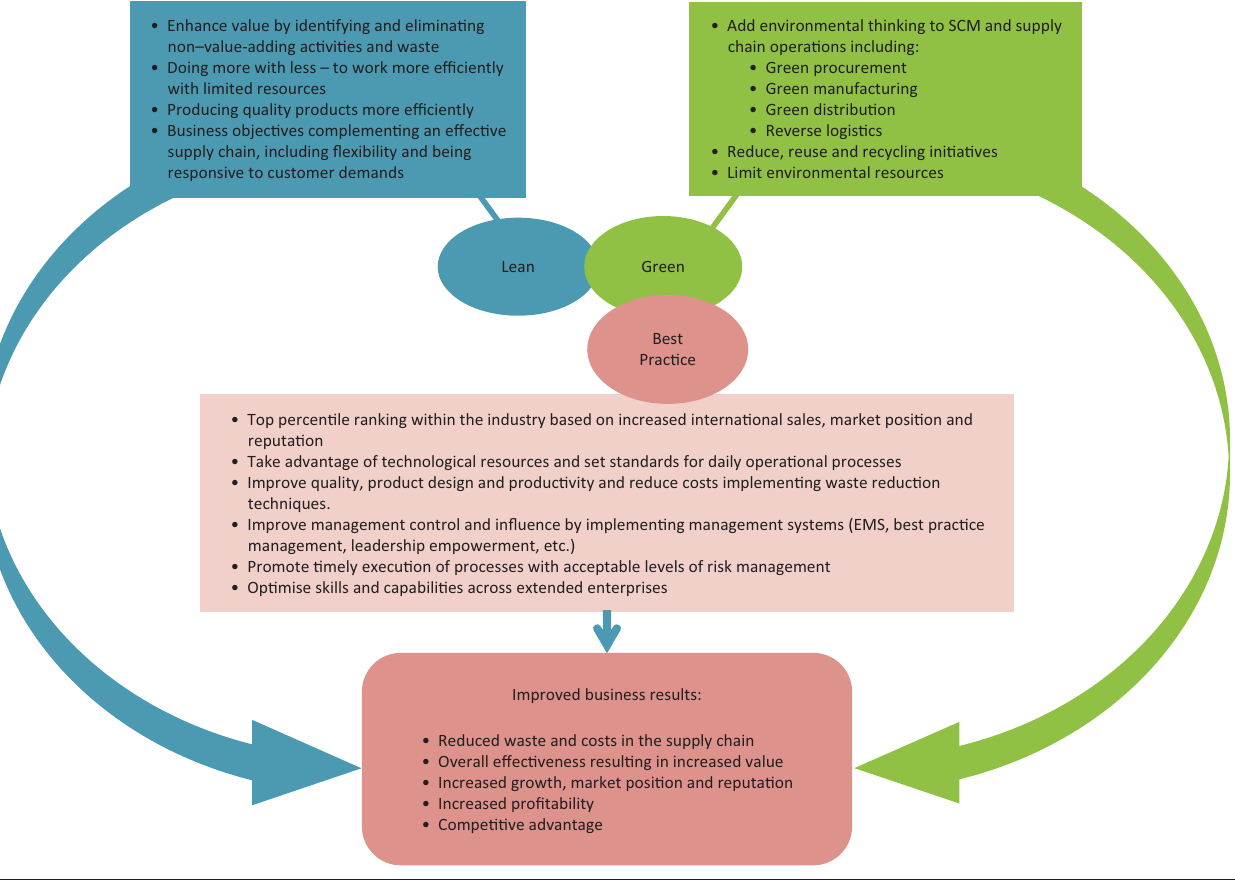
FIGURE 1: Key attributes of an integrated lean, green and best practice